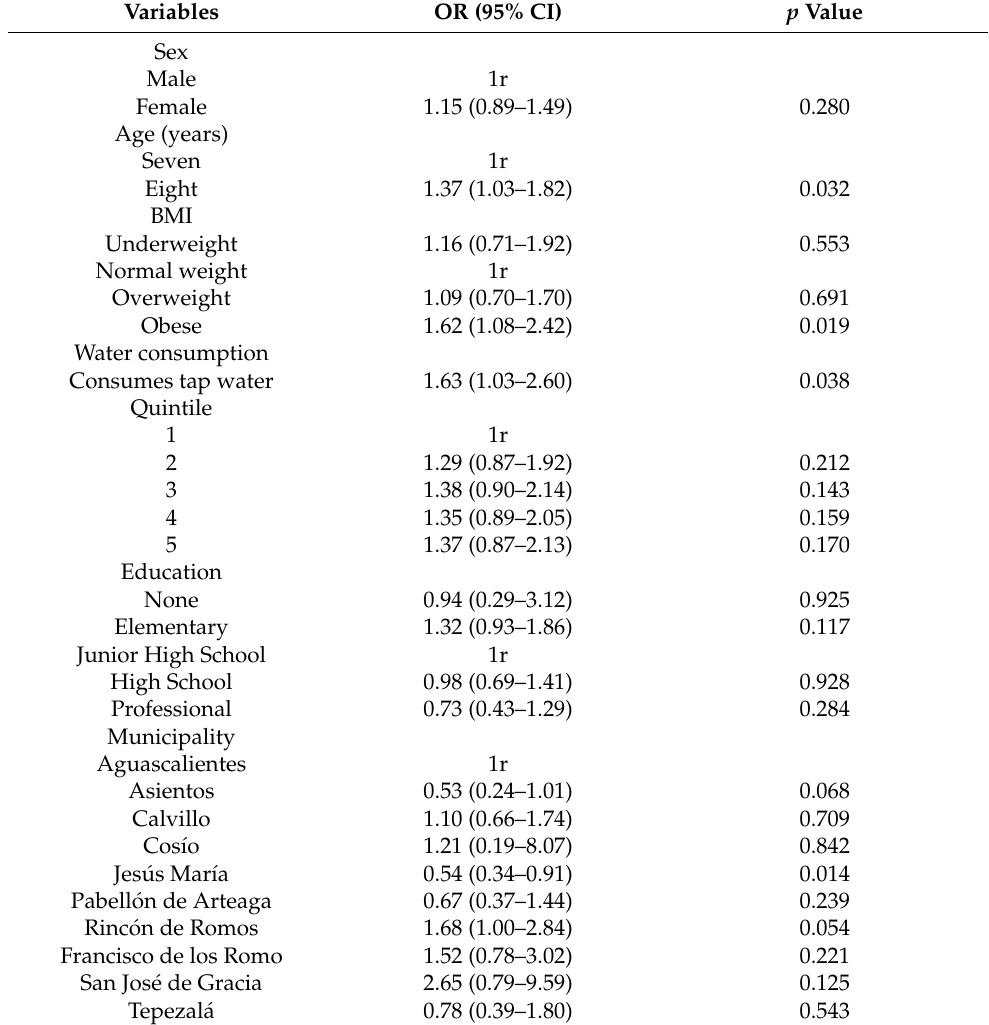
Table 3. OLR analysis for dental